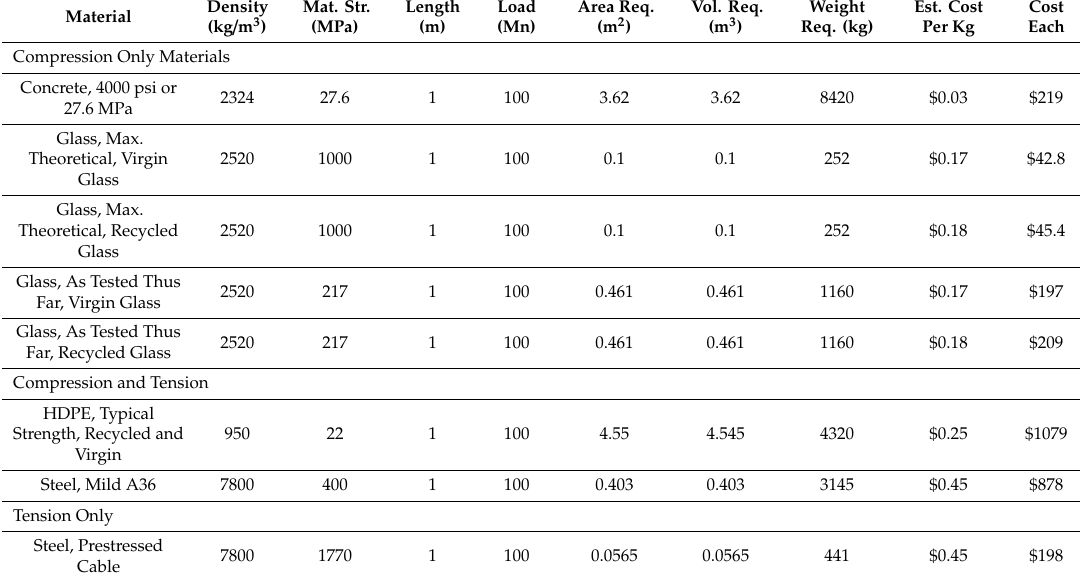
Table 1. The cost of materials required to resist 100 Mn applied to a variable cross-sectional area (i.e., axially loaded) and at a unit length of 1 m. The sections are divided by the loading types for the given materials so as not to directly compare compression-only to other material